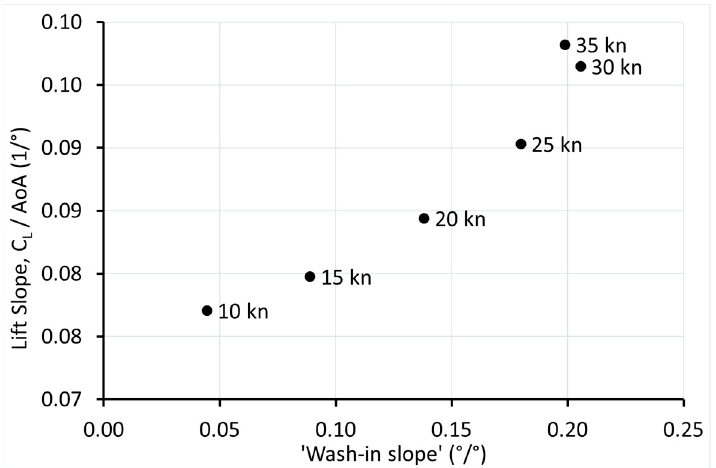
Figure 16. Lift slope–‘wash-in slope’ correlation.